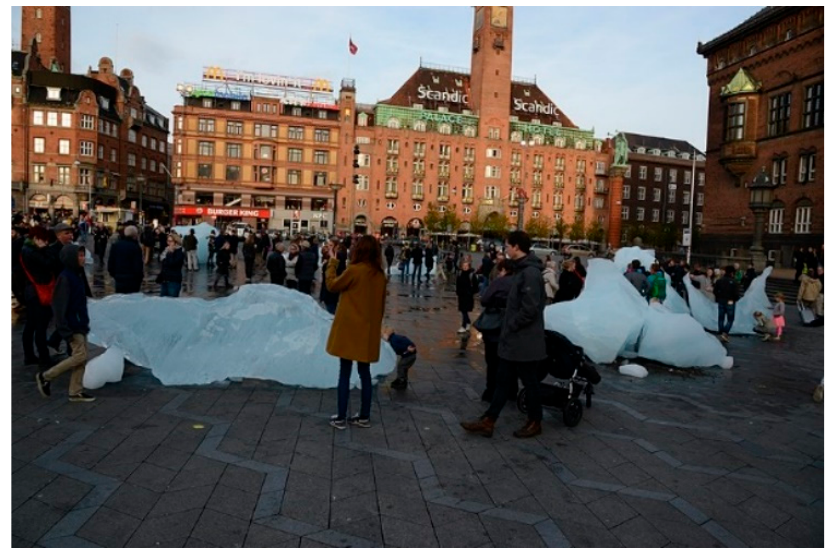
Figure 7. Ólafur Elíasson. Ice watch (Copenhagen, 2014, (Foto: Jorge Láscar, Melbourne, Australia). Source: https://commons.wikimedia.org/wiki/File:Ice_Watch_%2837898431101%29.jpg (accessed on 30 August 2022). Licensed under the terms of the cc-by-2.0.